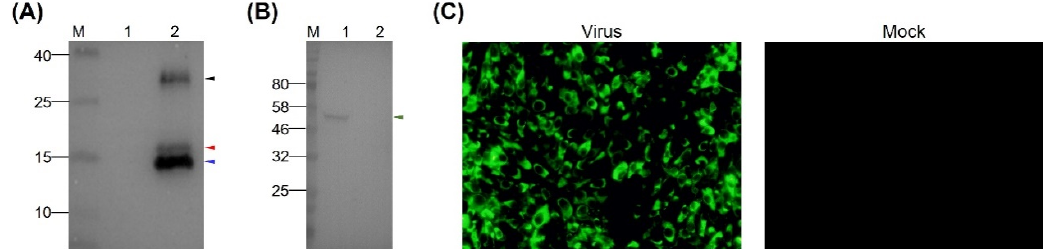
Figure 2. Identification of specificity of MAb 12F11. ( A ) Reactivity of 12F11 to rEDIII protein. Lane M, molecular weight marker; Lane 1, crude extracts from E. coli expressing PET-28a vector; Lane 2, purified rEDIII protein. ( B ) Reactivity of 12F11 to EDIII protein of virions. Lane M, molecular weight marker; Lane 1, virion-containing supernatant harvested from BHK-21 cells infected with TMUV Y; Lane 2, supernatant harvested from uninfected BHK-21 cells. The positions of the expected 16.7-kDa rEDIII protein and the 54-kDa E protein are indicated with red and green triangles respectively. The positions of the unexpected 15.8- and 30-kDa proteins are indicated with blue and black triangles, respectively. The numbers on the left of picture indicate molecular weight standards (in kDa). ( C ) Recognition of 12F11 to viral antigen expressed in infected cells using indirect immunofluorescence assay: (left) BHK-21 cells inoculated with TMUV Y and stained with 12F11 and FITC-conjugated goat anti-mouse IgG at 40 h post inoculation; and (right) uninfected BHK-21 cells.